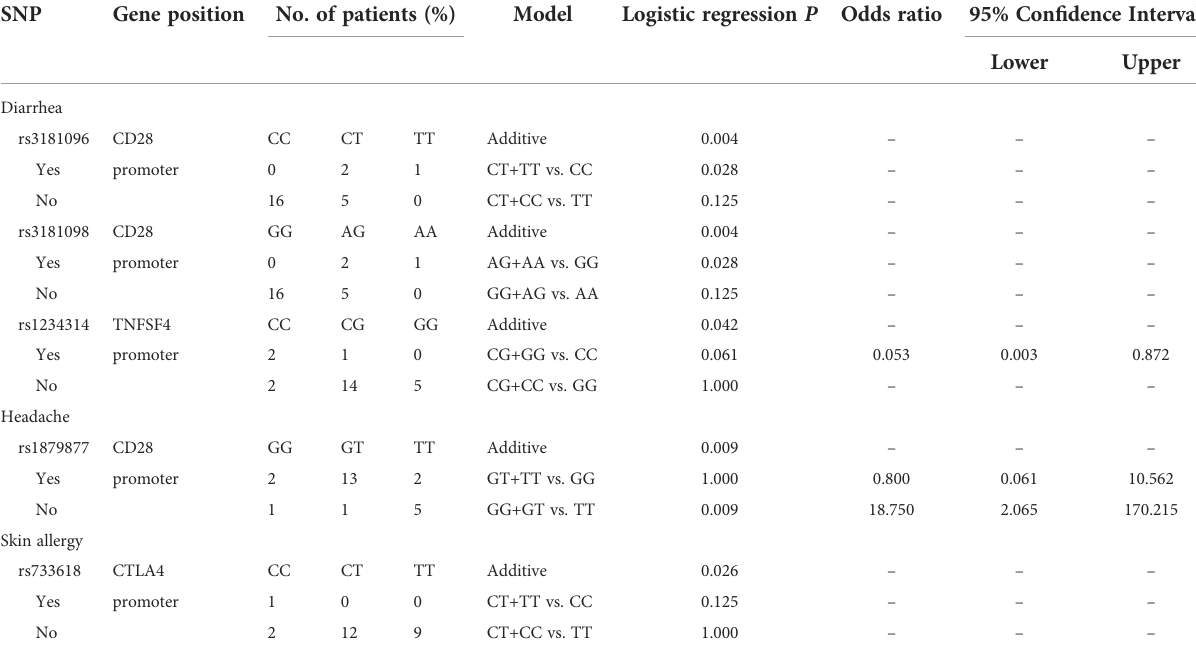
Additive: AA vs. Aa vs.